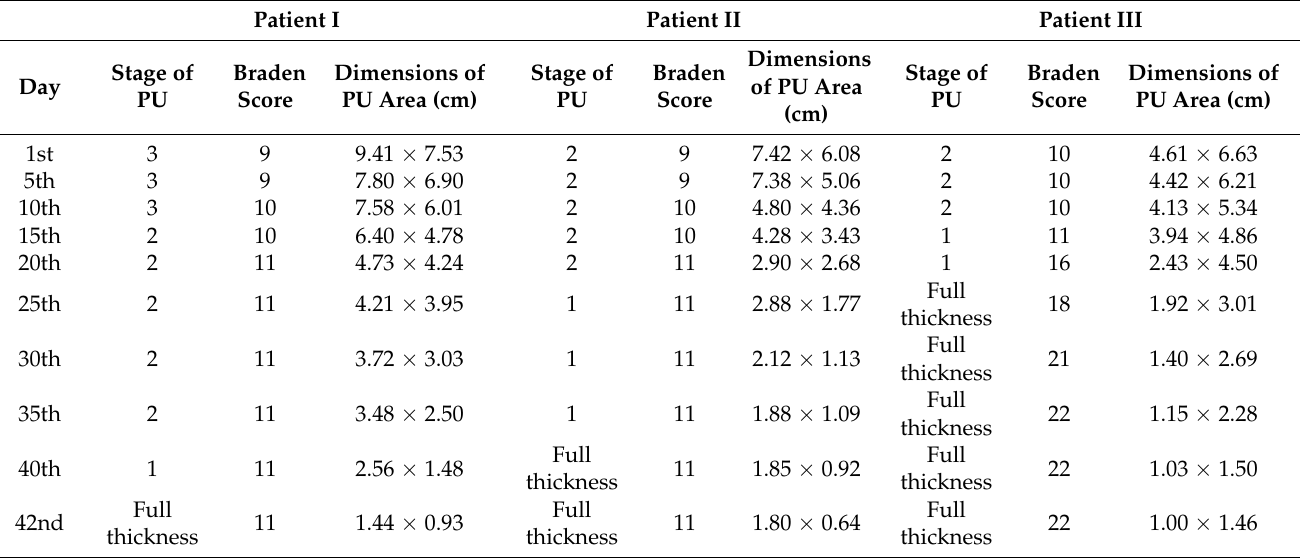
Table 1. Evaluation chart of the pressure ulcer (PU) of patients during the treatment